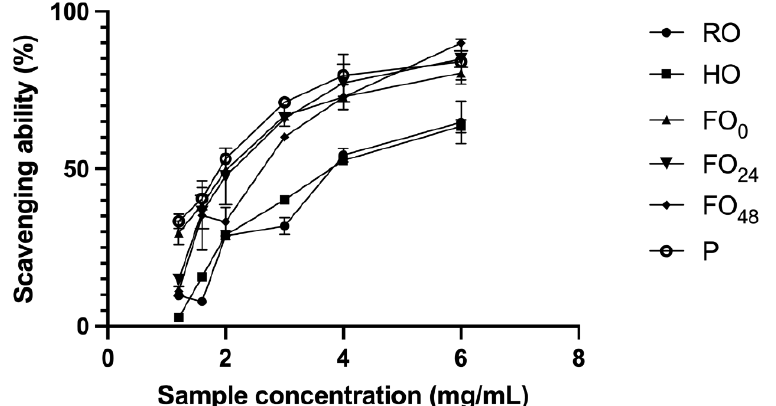
Figure 6. Scavenging ability of raw, hydrolyzed, and fermented oatmeal samples (RO, HO, FO 0 , FO 24 , FO 48 , and P, respectively) calculated at different sample concentrations. Each result represents the mean value of a triplicate analysis and error bars indicate the corresponding standard deviations.